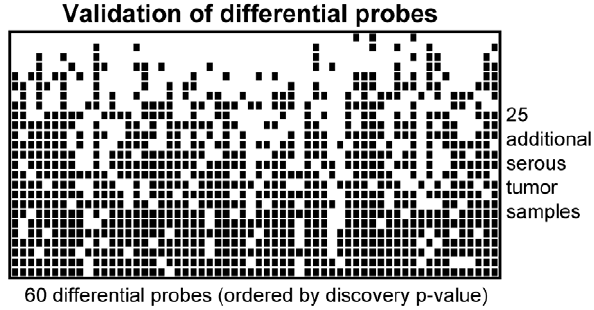
Figure 3. Classification of 25 additional serous tumors. Methylation at 60 loci was used to evaluate an independent set of serous tumors. Each row represents an individual sample; each column corresponds to one of the previously identified differentially methylated sites. An empty box indicates methylation more similar to the control cluster (not necessarily unmethylated); a filled black box indicates methylation more similar to the cluster of ovarian serous tumors. Samples are ordered by the number of sites having methylation resembling the serous tumor group. doi:10.1371/journal.pone.0032941.g003 PLoS ONE |